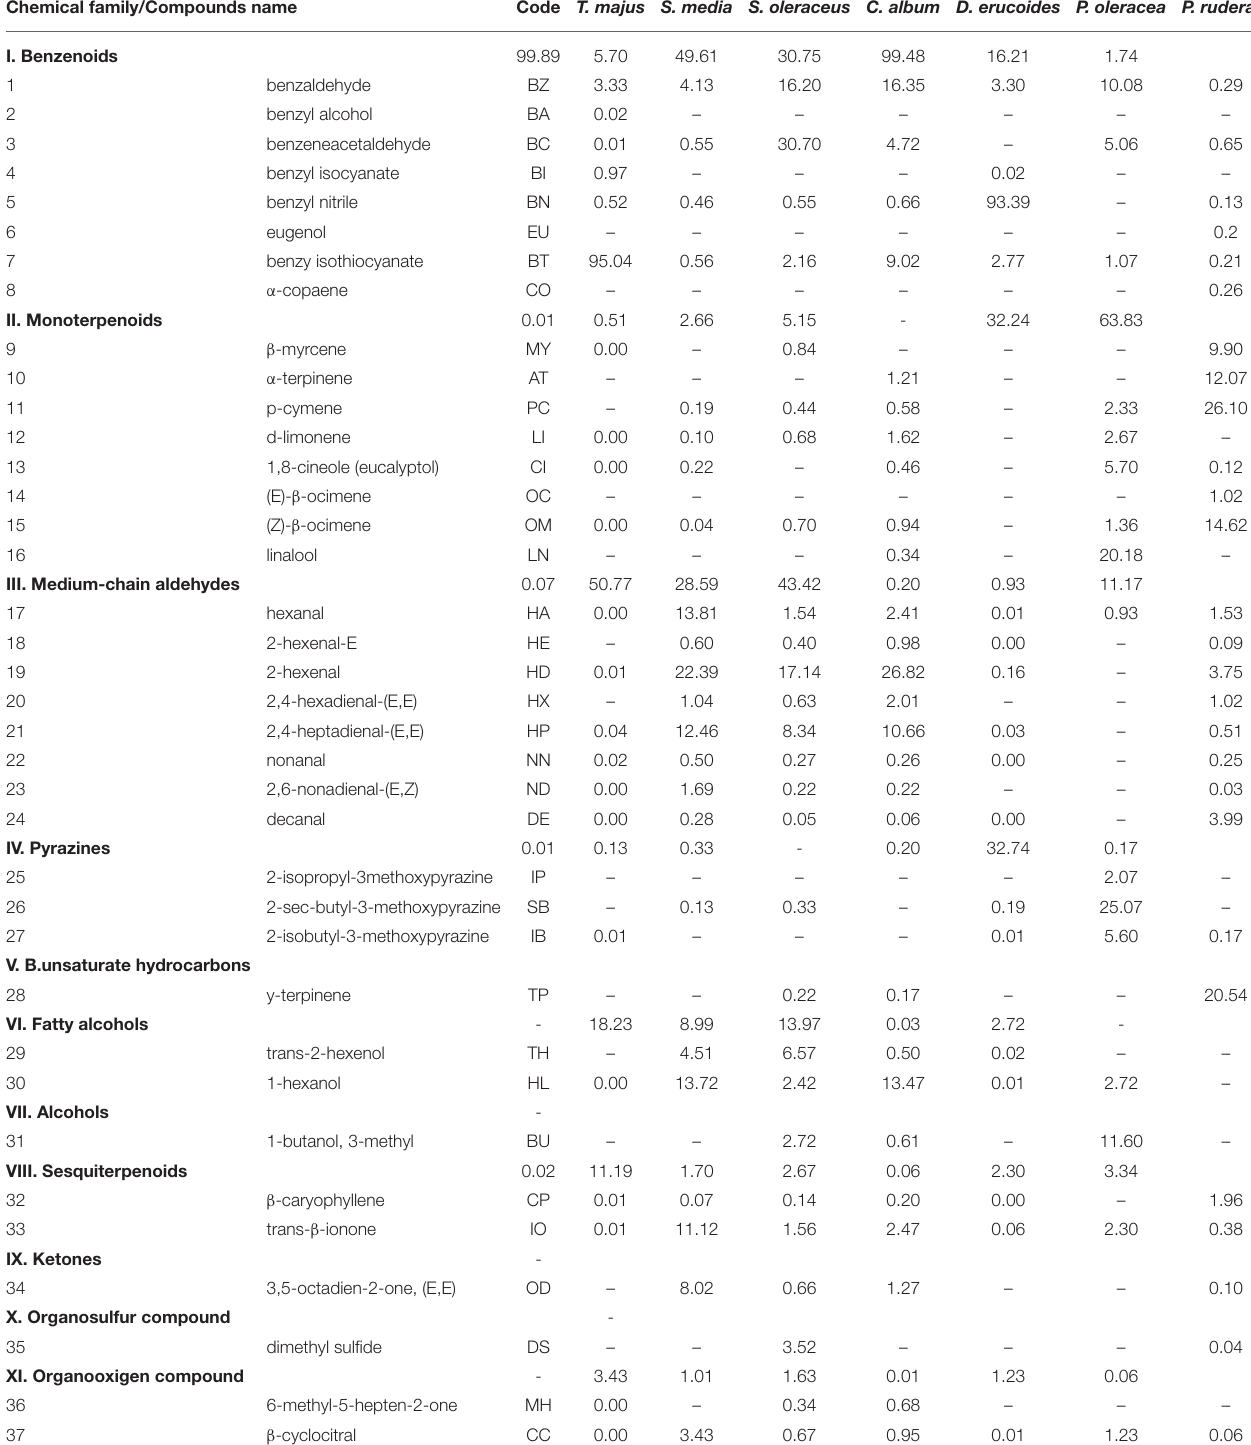
TABLE 2 | Mean relative abundances percentages (%) of chemical families and individual volatile compounds identified in the leaves of the seven undervalued species. Chemical family/Compounds